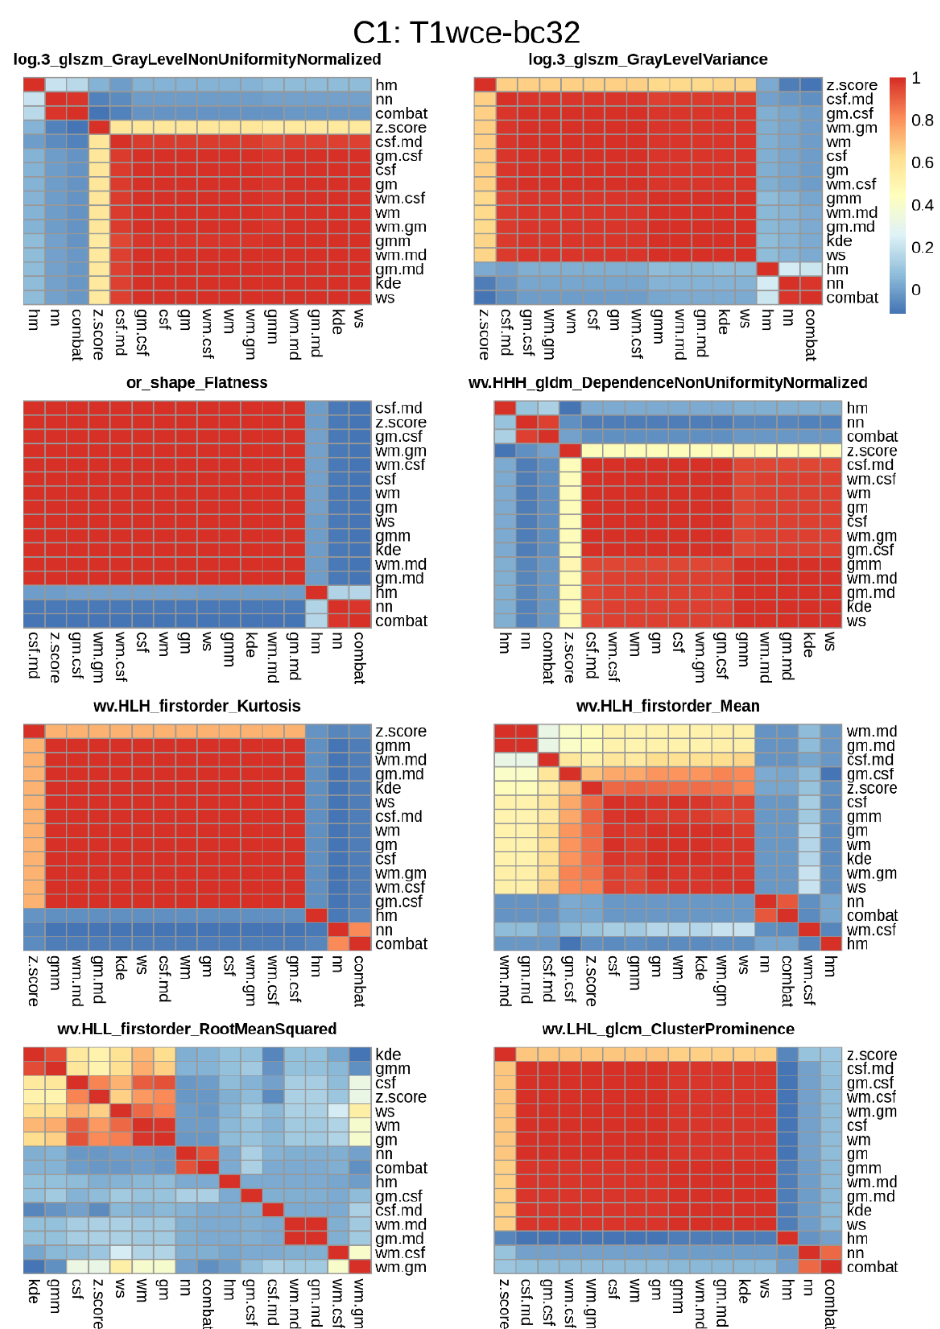
Figure 5. Significant feature correlation heatmaps between the 15 different normalization methods considered and the reference non-normalized dataset for T1wce images from cohort C1 discretized with a bin count of 32. Features with a high correlation (rs > 0.8) between at least 12 methods were further selected for modelling. Wv: Wavelet filter transformation, or: original image, log 3: Laplacian of gaussian transformation with a sigma of 3 mm.